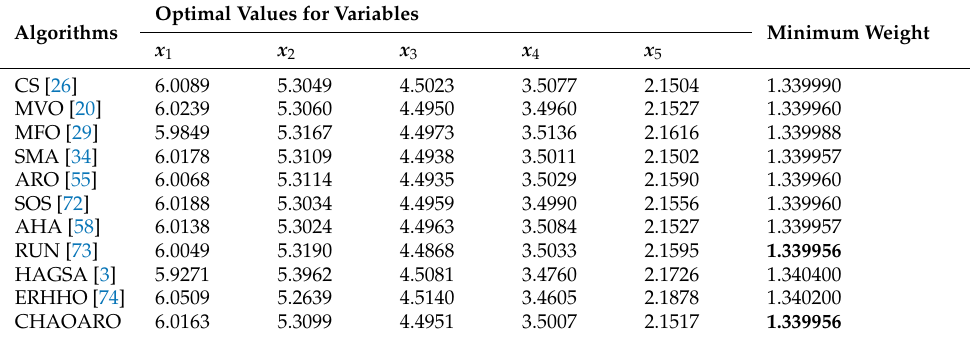
Table 13. Comparison results for cantilever beam design problem.